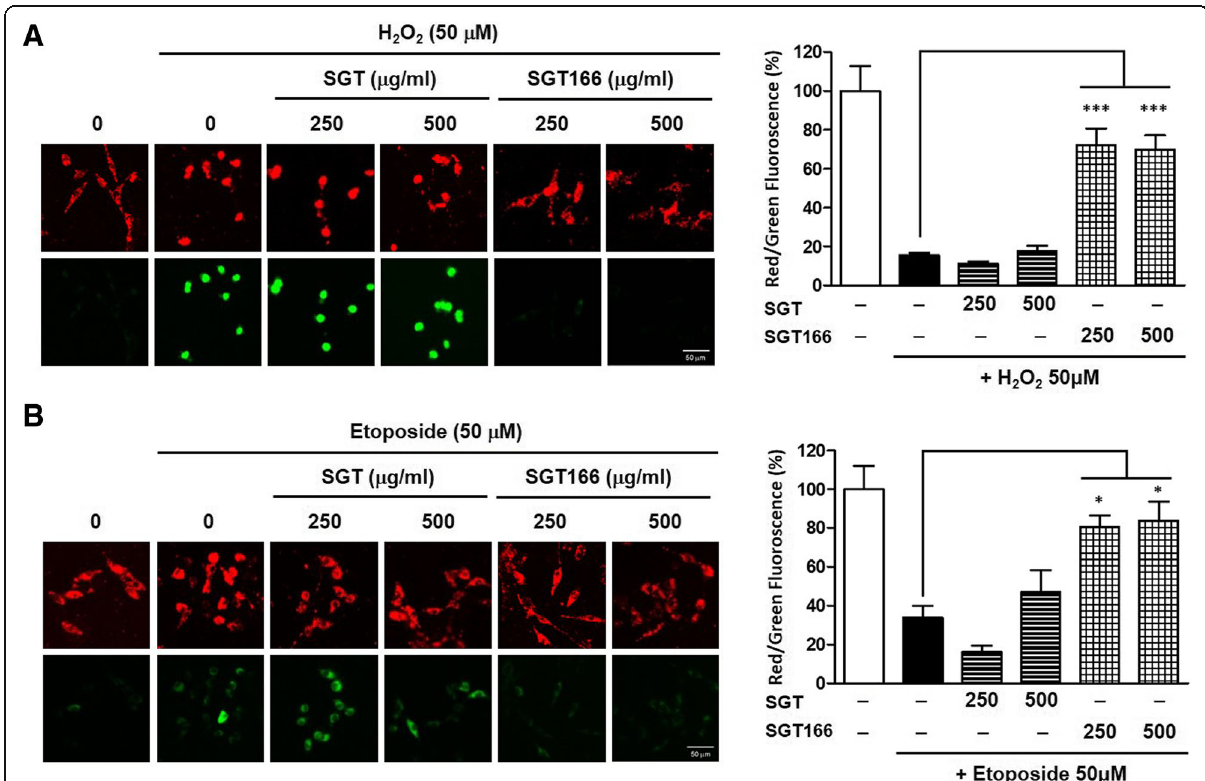
Fig. 6 The protective effects of SGT and SGT166 against toxicant-induced disruption of MMP in SH-SY5Y cells. MMP was assessed by confocal microscopy using JC-1 staining. Cells were pretreated with SGT or SGT166 for 6 h, and then separately exposed to 50 μ M H 2 O 2 ( a ) and 50 μ M etoposide ( b ) for 1 h. After incubated with JC-1 for 15 min, the cells were observed under 132x magnification. Representative images showing red fluorescence (aggregated form) and green fluorescence (monomeric form). Scale bar = 50 μ m. The graph shows the red/green fluorescence intensity ratio quantitative analysis. The values shown are means ± SE ( n = 5). * P < 0.05 and *** P < 0.001 versus the cells treated with toxicant